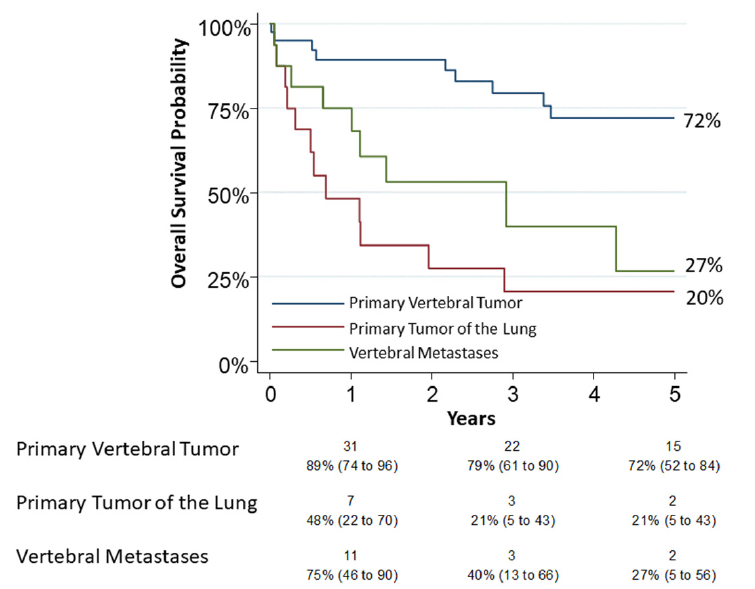
Figure 2. The 5-year overall survival for group 1 (primary vertebral tumors), group 2 (primary tumors of lung infiltrating spine) and group 3 (vertebral metastases) was 72% (95% CI: 0.52–0.84), 20% (95% CI: 0.05–0.43) and 27% (95% CI: 0.05–0.56), respectively. Numbers below the time axis are patients at risk and Kaplan–Maier estimates (95% CI). Table 2. Clinical features of the sample based on type of tumor. A remarkable heterogeneity was observed in the sample. Group 1 tumor is defined as mesenchymal primary tumors, group 2 as primary tumors of the lung infiltrating the vertebrae and group 3 as vertebral metastases. Alive Dead Odds Conf. p Value p (60 Months) (60 Months) Ratio Interval